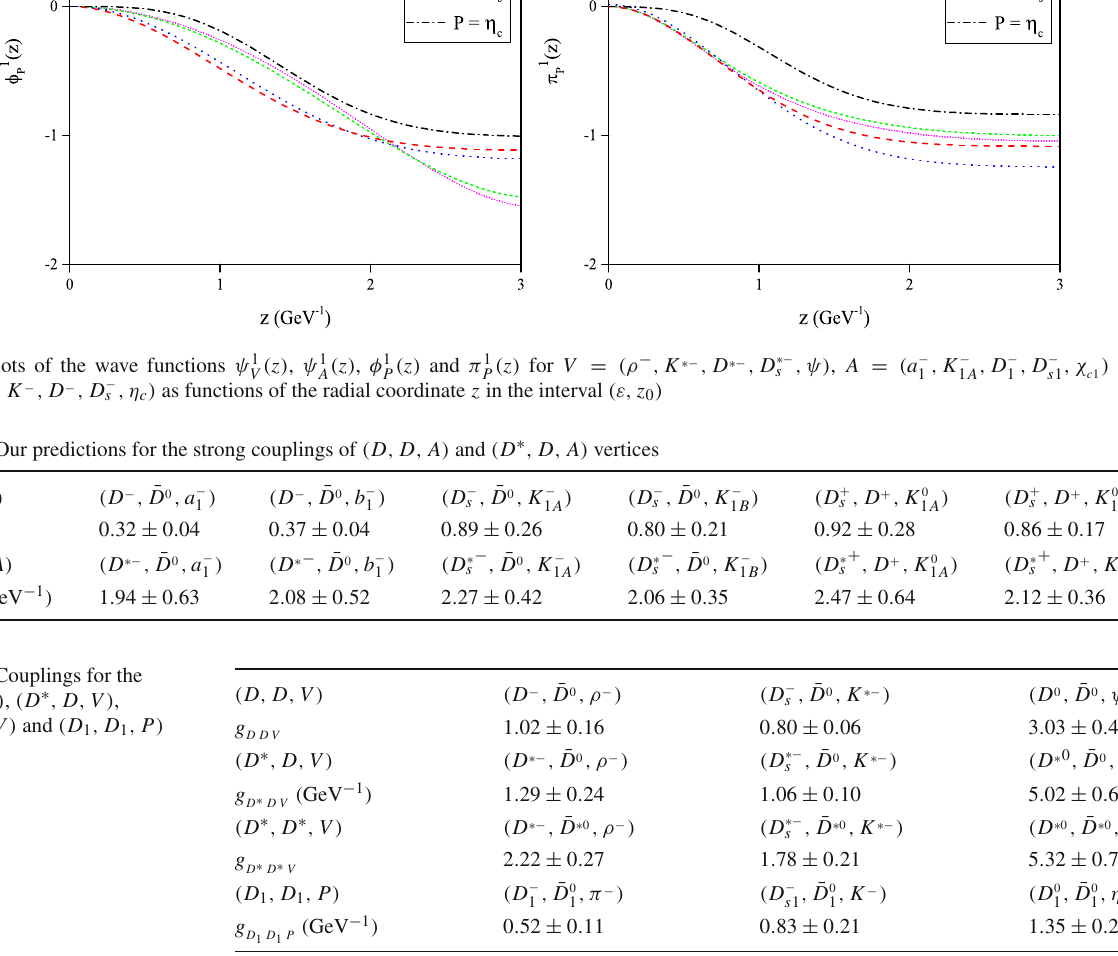
Table 6 Couplings for the ( D , D , V ) , ( D ∗ , D , V )